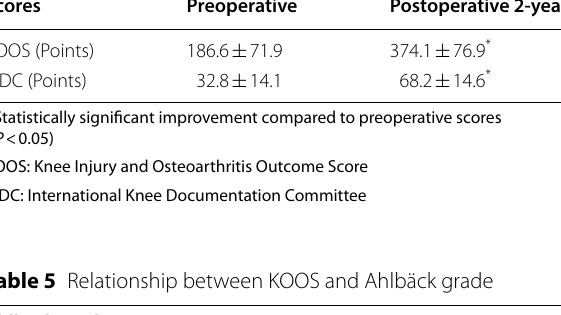
Table 5 Relationship between KOOS and Ahlbäck grade